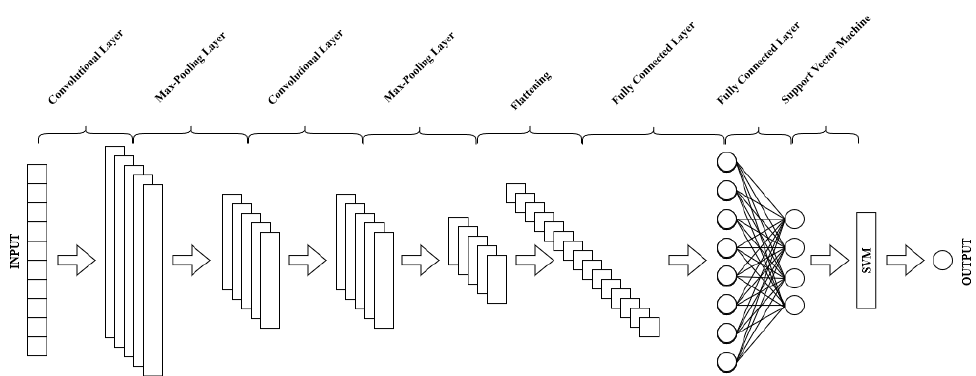
Figure 3. General structure of the proposed hybrid